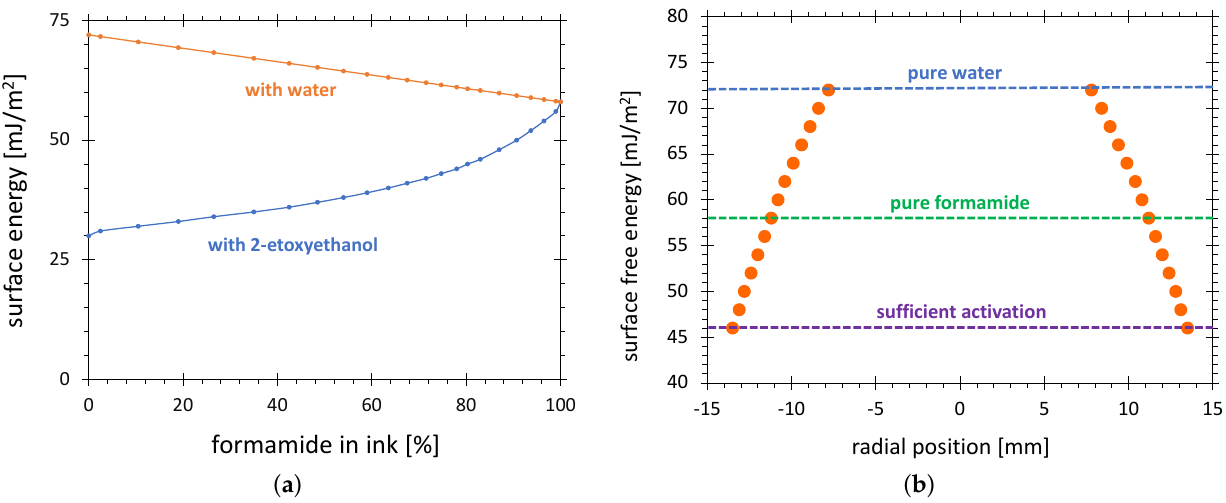
Figure 4. Determination of the SFE by use of the test inks. ( a ) The SFE gauged by the test ink consisting of formamide mixed with 2-ethoxyethanol (blue curve, according to [49]) and formamide mixed with water (red line, linear approximation) as a function of formamide volume percentage; ( b ) The typical radial distribution of the SFE after HDPE treatment in configuration C. The SFE levels for water and formamide test inks, and for the levels sufficient for printing on HDEP, are depicted with dashed